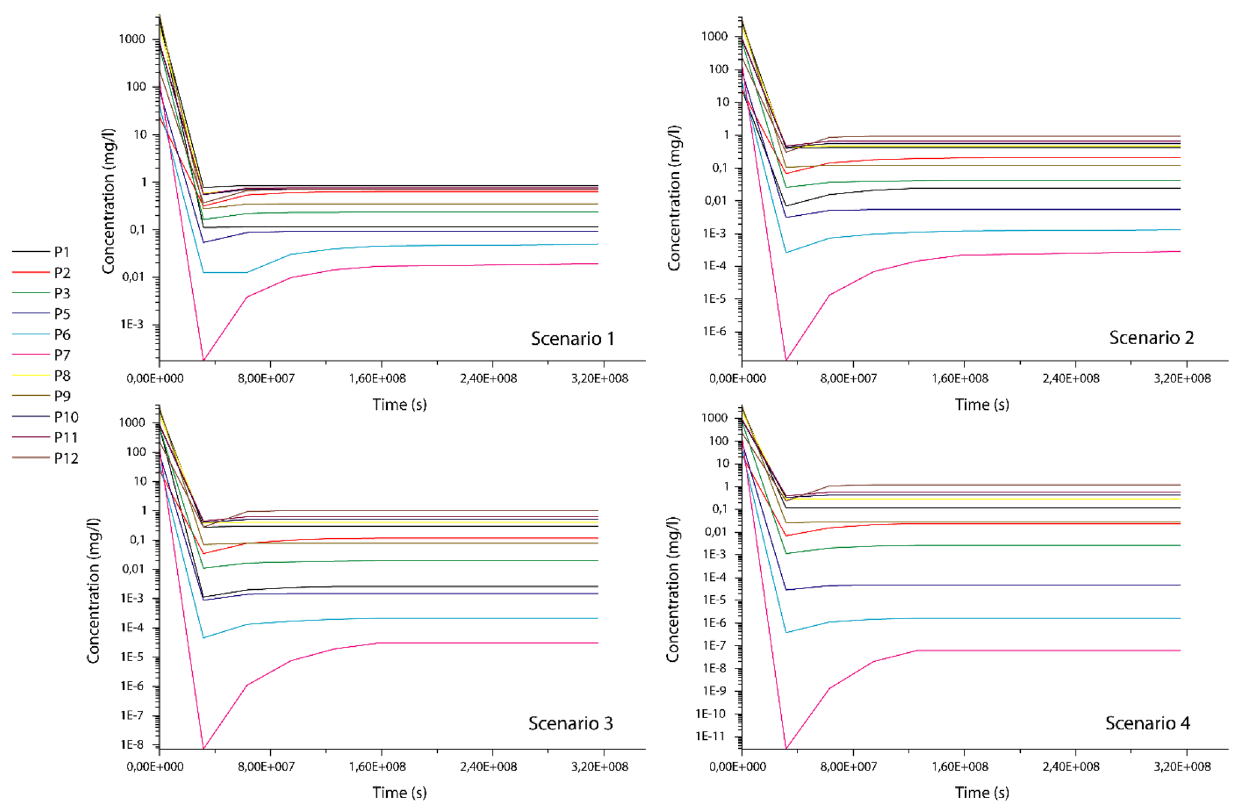
Fig. 11 Simulated sulfate concentration under remediation conditions of the four scenarios at 1, 5 and 10 years